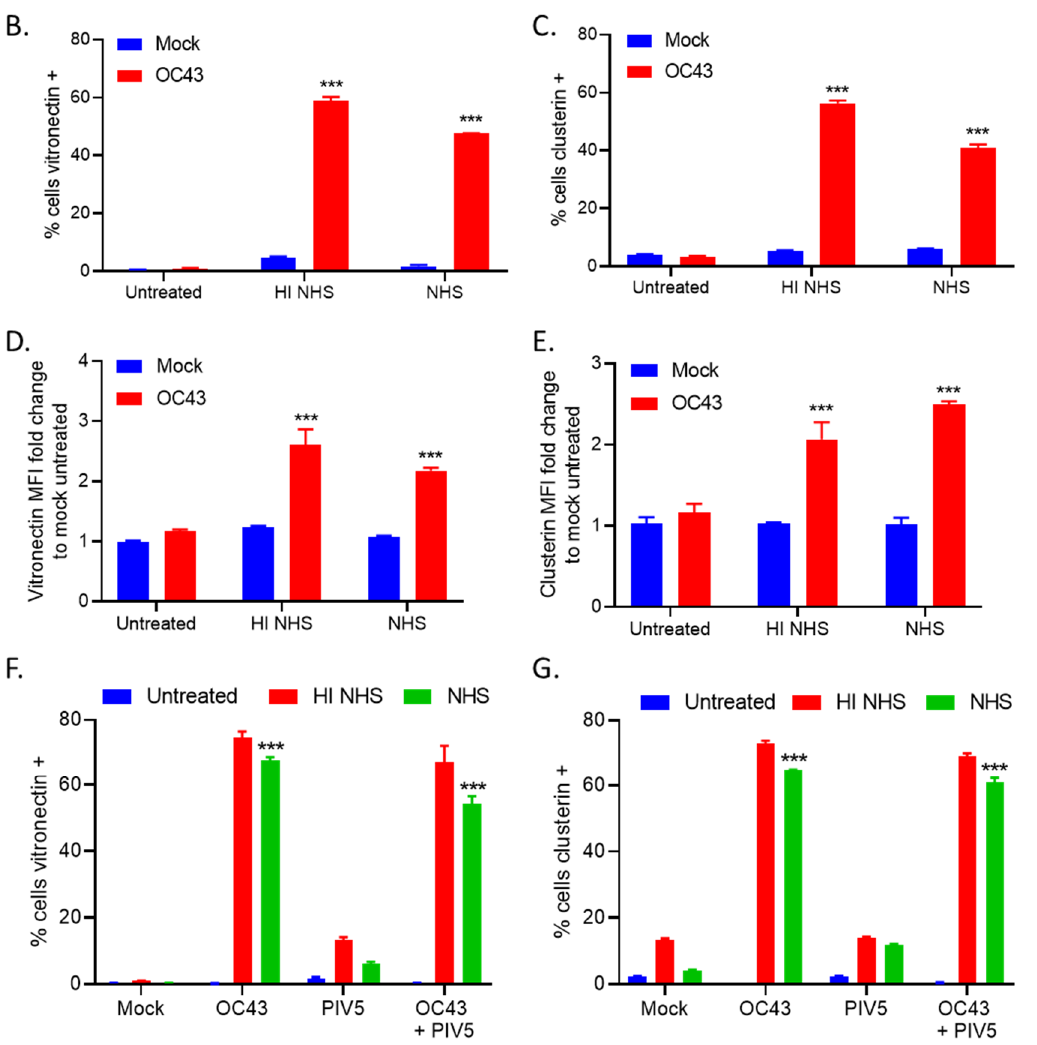
Figure 6. OC43 infected lung cells recruited VN and CLU from NHS. ( A ) Uninfected (mock) or OC43 infected H1299 cells were either left untreated, or treated with HI NHS, or NHS for 1 h. Cells were washed and lysates were probed for VN and CLU. ( B – E ) Uninfected (mock) or OC43 infected cells were left untreated or treated with 10% HI NHS, or 10% NHS for 1 h before staining for surface binding of VN ( B ), or CLU ( C ). Data are expressed as percentage that are antibody positive ( B , C ) or MFI ( D , E ). ( F , G ) Cells that were uninfected (mock), or singly infected with OC43 or PIV5, or co-infected with PIV5 and OC43 were either left untreated, or treated with HI NHS, or NHS for 1 h and stained for surface binding of VN ( F ) or CLU ( G ). Values in all panels are the mean of three replicates and error bars representing standard deviation, with *** indicating p -value of <0.001 comparing HI NHS or NHS treated infected cells versus HI NHS or NHS treated uninfected (mock) samples. Mock denotes uninfected control samples.